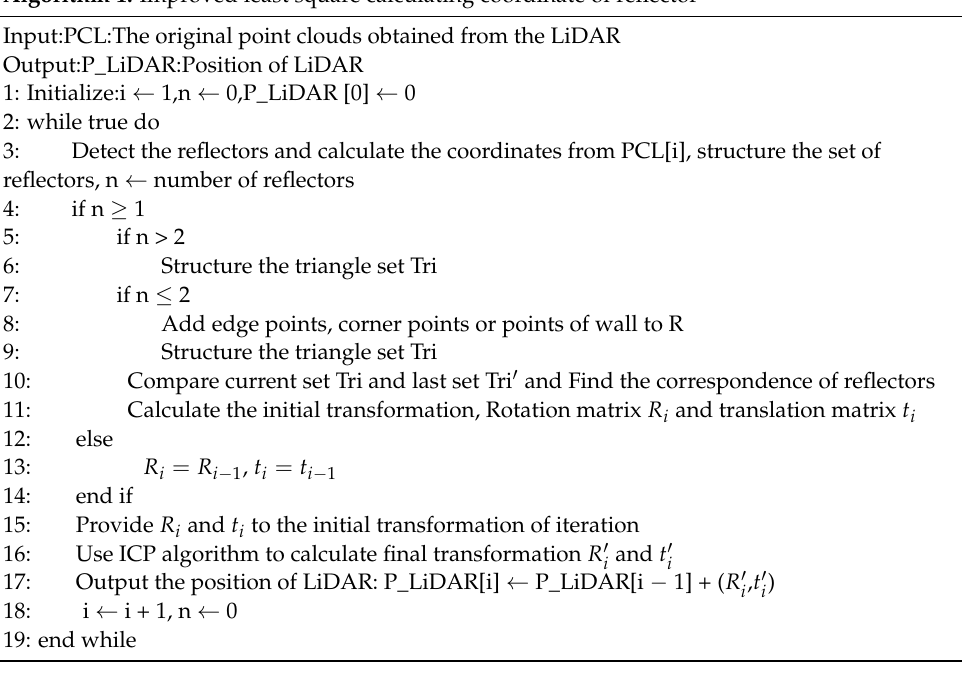
Algorithm 1. Improved least square calculating coordinate of